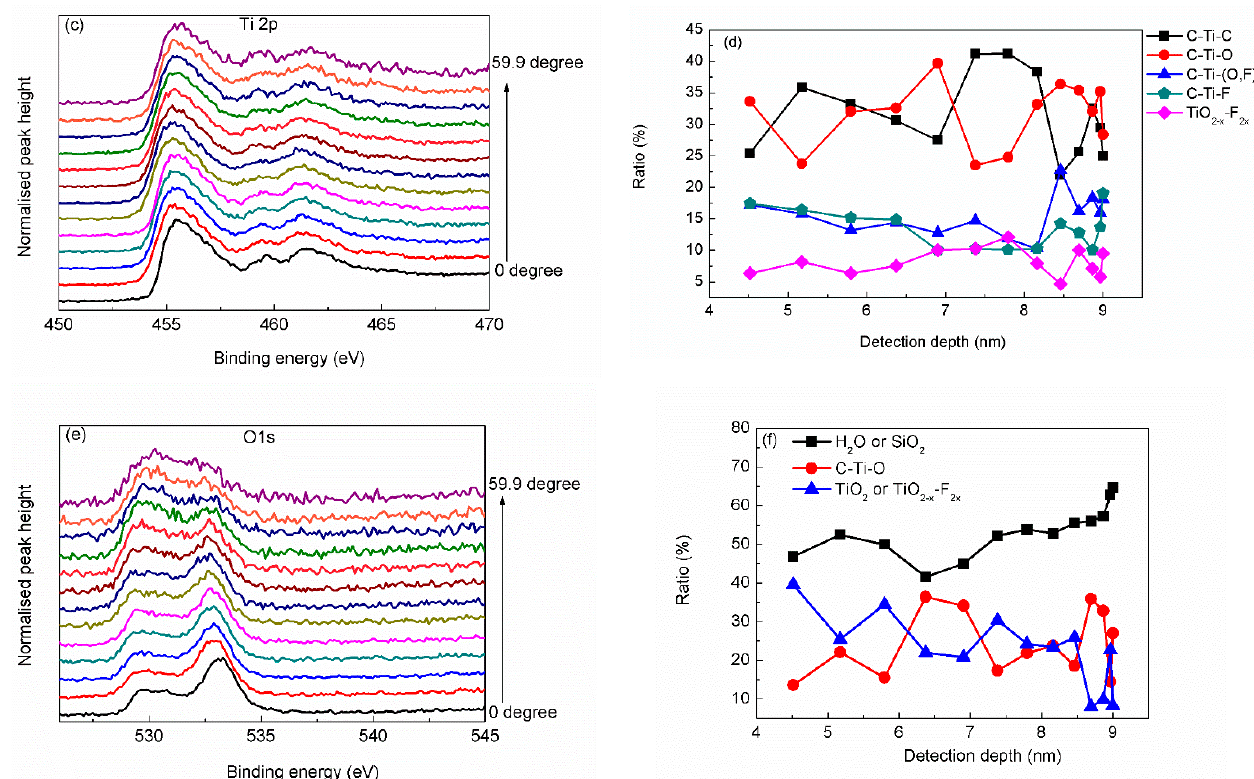
Figure 3. Narrow scanning angle-resolved distribution and state ratio angle-related depth profile of C 1s ( a , b ), Ti 2p ( c , d ) and O 1s ( e , f ). In order to further characterize the structure of the Ti 3 C 2 T x MXene, argon ion etching was adopted to analysis the Ti 3 C 2 T x MXene sample layer-by-layer. The top surface of the sample was etched by argon ion, and the newly exposed surface was analyzed by XPS, with the results as shown in Figures 4–8.